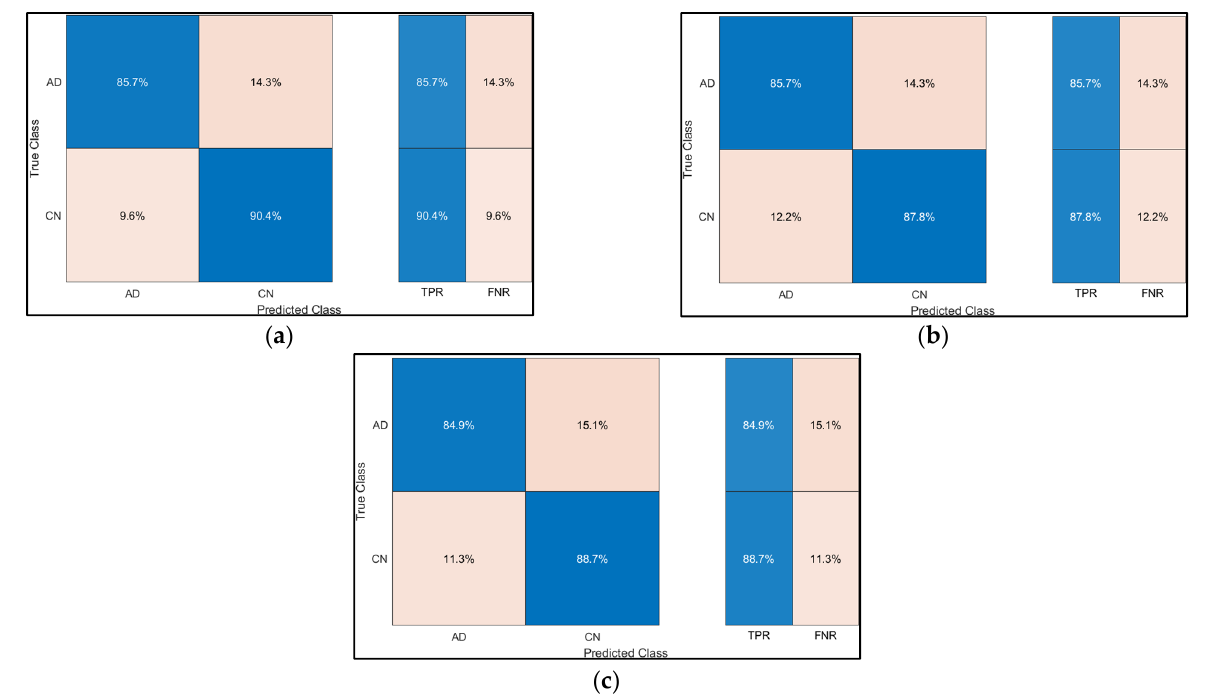
Figure 11. Confusion Matrix for ( a ) SVM, ( b ) Decision Tree, and ( c ) Ensemble.